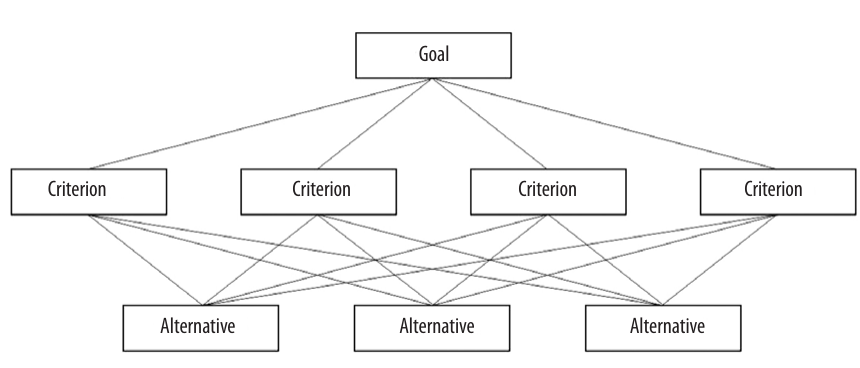
Fig. 1. AHP conceptual structure Source : Saaty (2008,